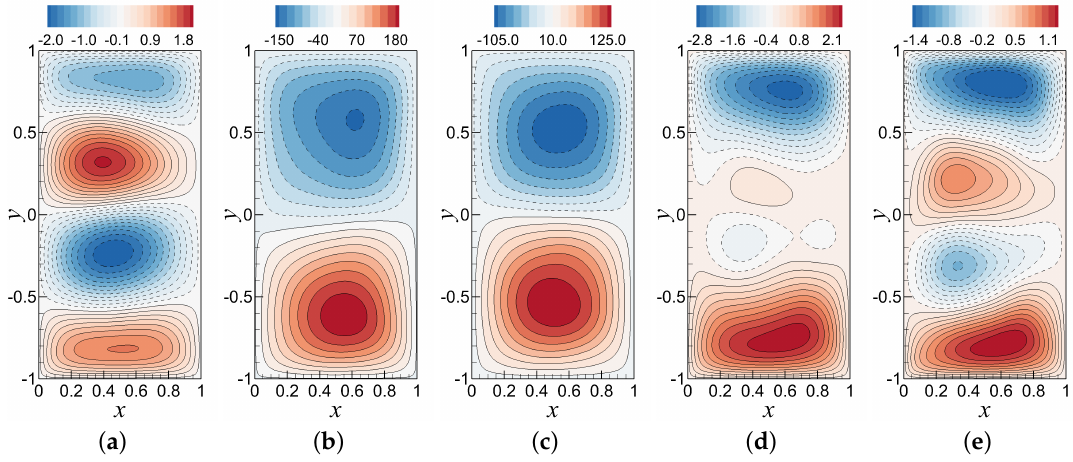
Figure 7. Mean stream function contour plots between t = 15 and t = 60 obtained by reference FOM and standard ROM-GP simulations for Re = 400: ( a ) ψ FOM at a resolution of 128 × 256; ( b ) ψ ROM-GP with R = 10 modes; ( c ) ψ ROM-GP with R = 20 modes; ( d ) ψ ROM-GP with R = 30 modes; and ( e ) ψ ROM-GP with R = 40 modes. Note that a stable and well-estimated solution can be found within R = 40 modes for this case.